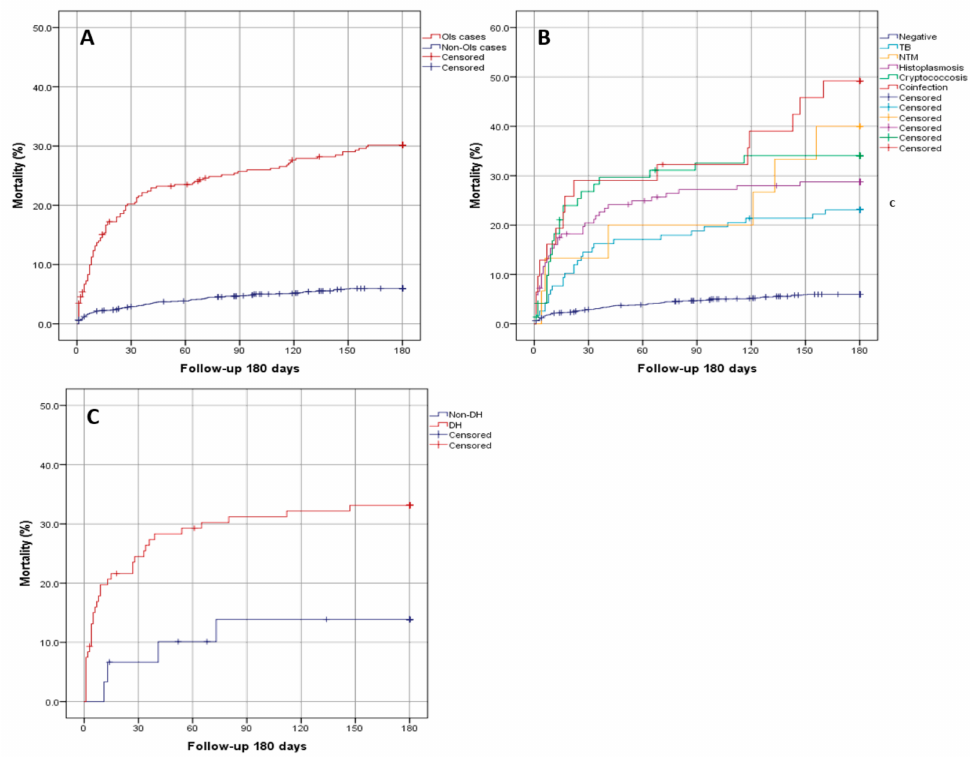
Figure 1. Kaplan–Meier survival curves. ( A ) Patients with and without opportunistic infections. ( B ) Patients without opportunistic infections, with tuberculosis, nontuberculous mycobacteria, cryptococcal disease, histoplasmosis, and with multiple opportunistic infections. ( C ) Patients with disseminated histoplasmosis and non-disseminated